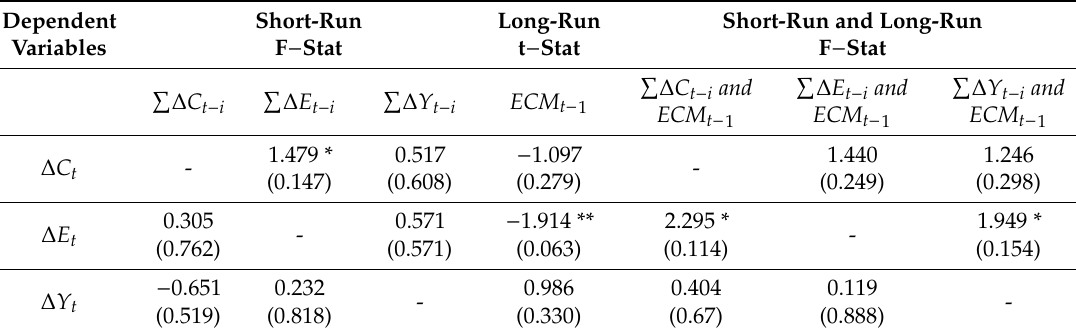
Table 9. Causality results